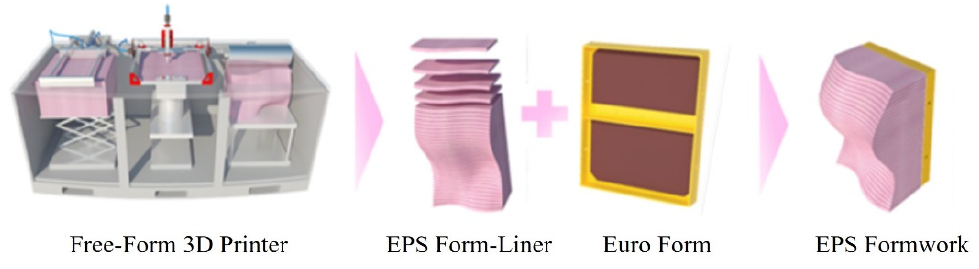
Figure 1. Process of EPS formwork.